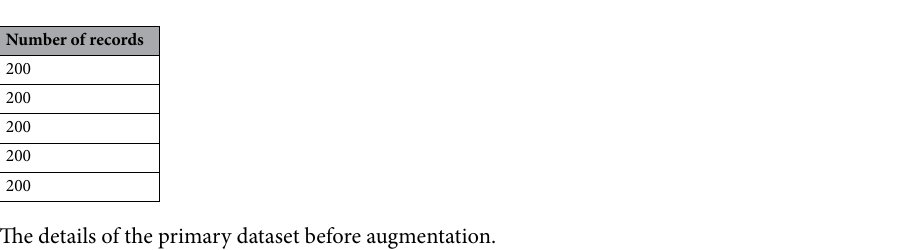
Table 1. The details of the primary dataset before